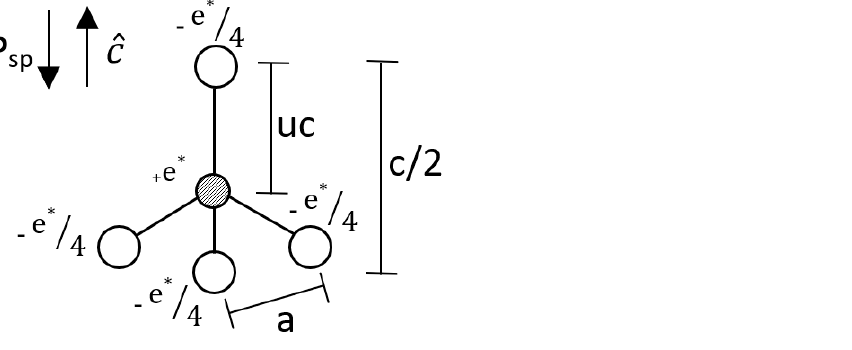
Figure 1. Point charge model of a elementary wurtzite unit cell along with lattice parameters.